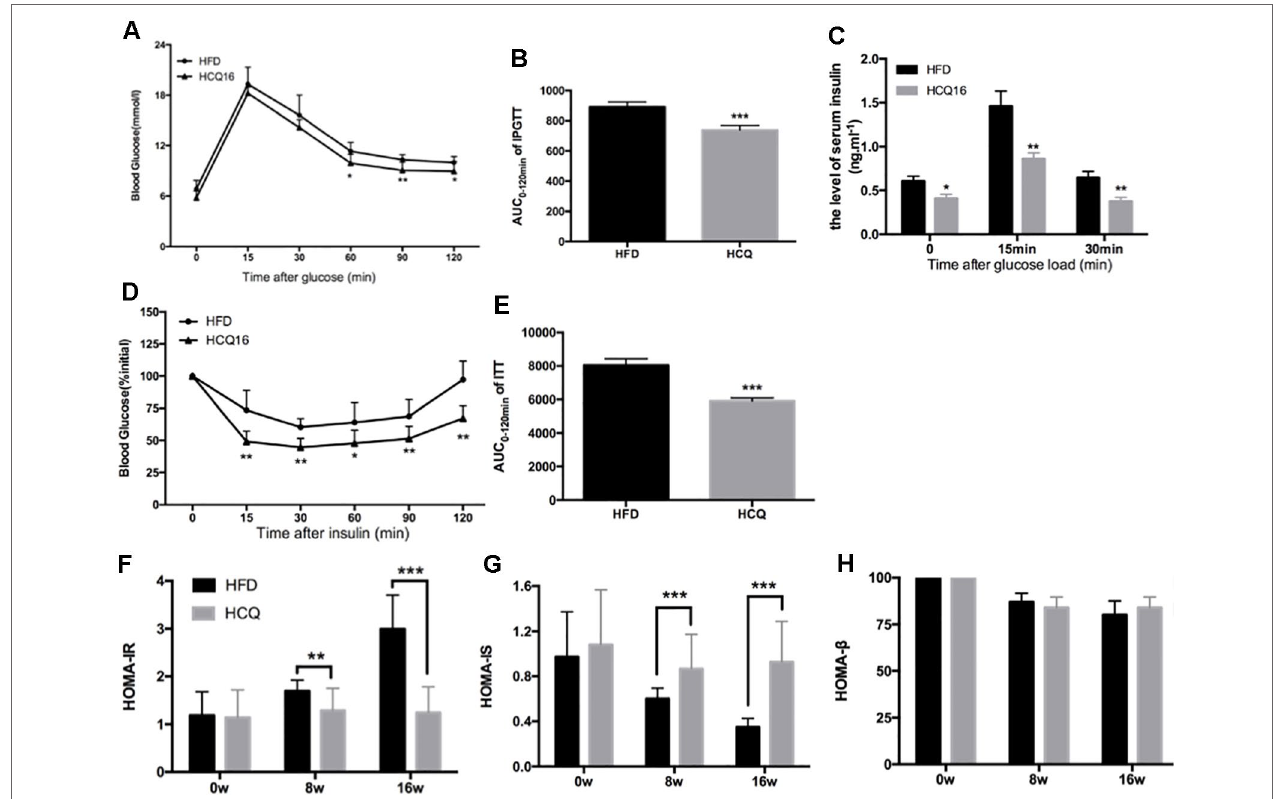
FIGURE 2 | HCQ improved glucose homeostasis and insulin sensitivity in HFD-fed mice. (A) The i.p. glucose tolerance test on HDF mice treated by injecting 0.75 g of glucose per kg after overnight fasting. (C) Serum insulin concentration at 0-min (fasted overnight) and after glucose load at 15 and 30 min during the i.p. glucose tolerance test. (D) The insulin tolerance test was evaluated throughout the study, and 1 U of insulin per kg was injected after 6 h of fasting. (B and E) The AUC of the IPGTT and ITT is shown. (F) The homeostasis model assessment-estimated insulin resistance (HOMA-IR). (G) The insulin sensitive index (HOMA-IS). (H) The basic function of pancreatic β cell (HOMA- β ). Values were presented as mean ± standard error of the mean (SEM). The error bars represent the SEM ( n = 8–10). Significant differences compared with HFD group controls were indicated by * P < 0.05, ** P < 0.01, and *** P < 0.001 (assessed by Student’s t